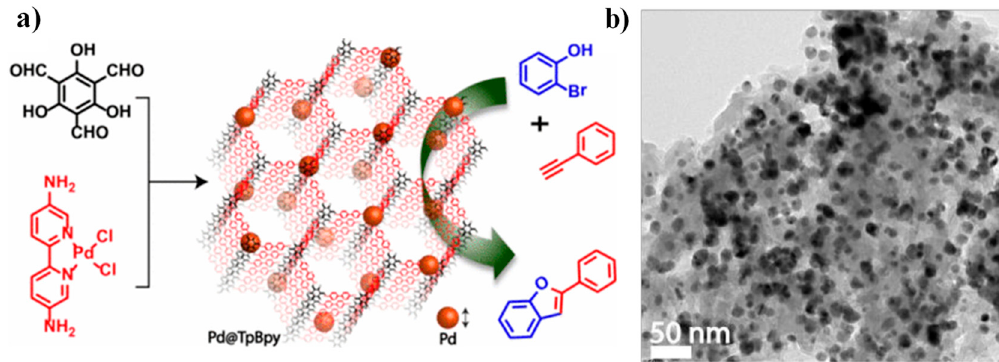
Figure 10. ( a ) Schematic illustration of the composite synthesis and ( b ) a TEM image of Pd NP − TpBpy composite. Reprinted with permission from [59]. Copyright (2017) American Chemical